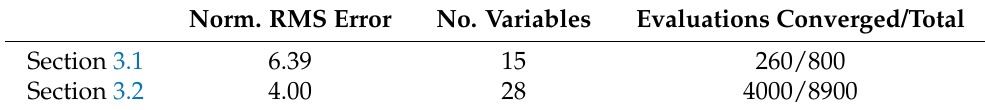
Table 2. Comparison of applied methods on cam-follower case for converged optimization solutions. Norm. RMS